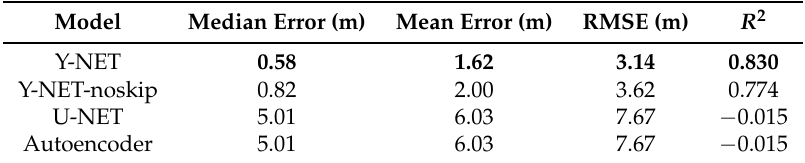
Table 2. Statistical performance of each model given the testing dataset (70.42 million pixels). Y-NET outperforms all other models for every metric in our evaluation. The best result for each metric is in